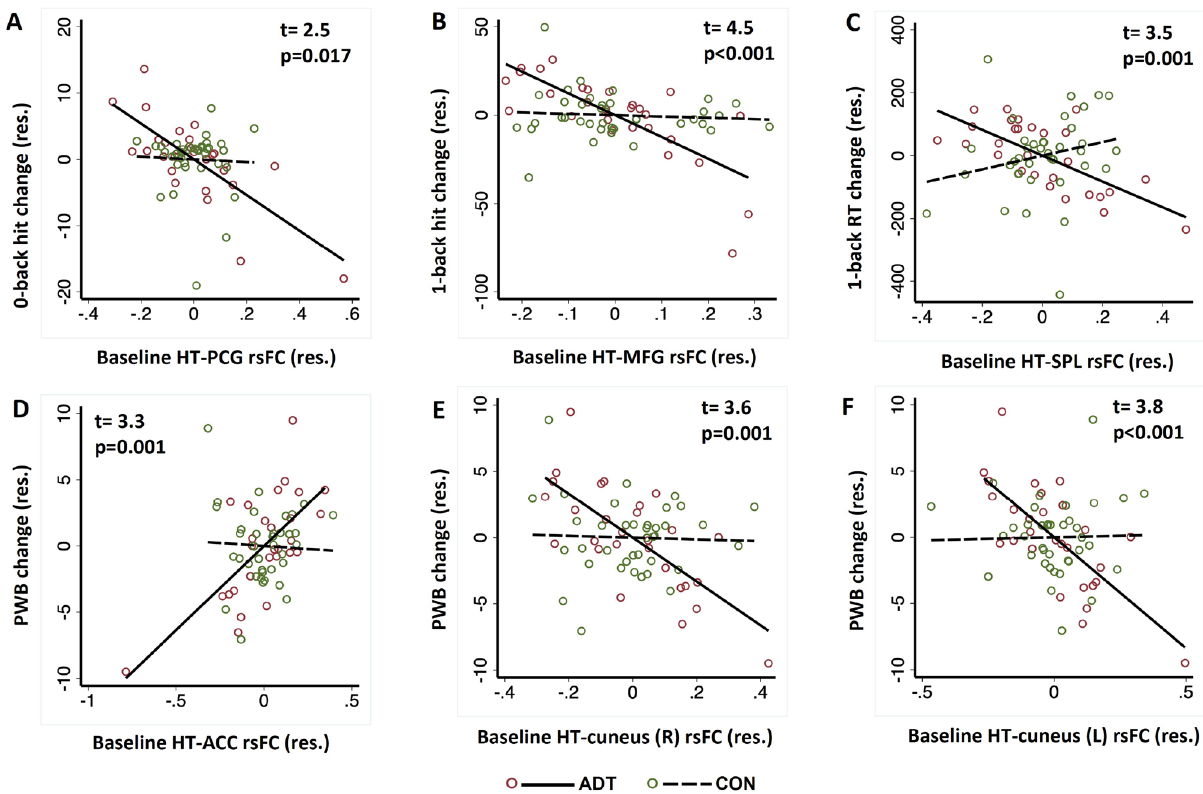
Figure 3. Pearson’s partial correlation between baseline hypothalamus (HT)—( A ) bilateral precentral gyrus (PCG) rsFC and change (follow-up—baseline) in 0-back correct response rate (hit %); ( B ) right MFG rsFC and change in 1-back hit %; ( C ) left superior parietal lobule (SPL) rsFC and change in 1-back reaction time (RT); ( D ) left anterior cingulate cortex (ACC) rsFC and change in PWB; ( E / F ) right/left cuneus rsFC and change in PWB. Note that, because of the inclusion of covariates in the regression, the residuals are plotted here. The covariates included baseline age, years of education, and MoCA score. The insets show the t- and p-values of slope tests of ADT vs. CON in the